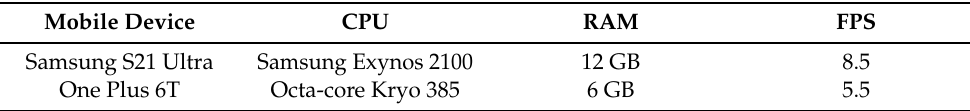
Table 3. Mobile device hardware specification and FPS during inference.